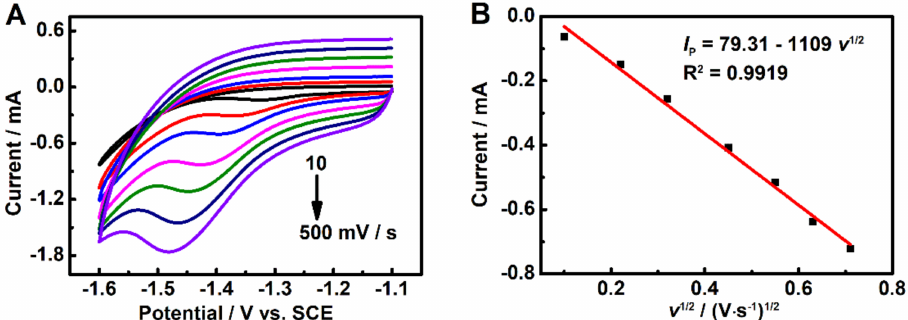
Figure 5. ( A ) CVs of 50- µ M HMF in pH 9.18 PBS solution with scan rates from 10 to 500 mV s − 1 . ( B ) The linear relationship between the reduction peak current ( I p,c ) of HMF and the square root of the scan rate ( v 1/2 ).